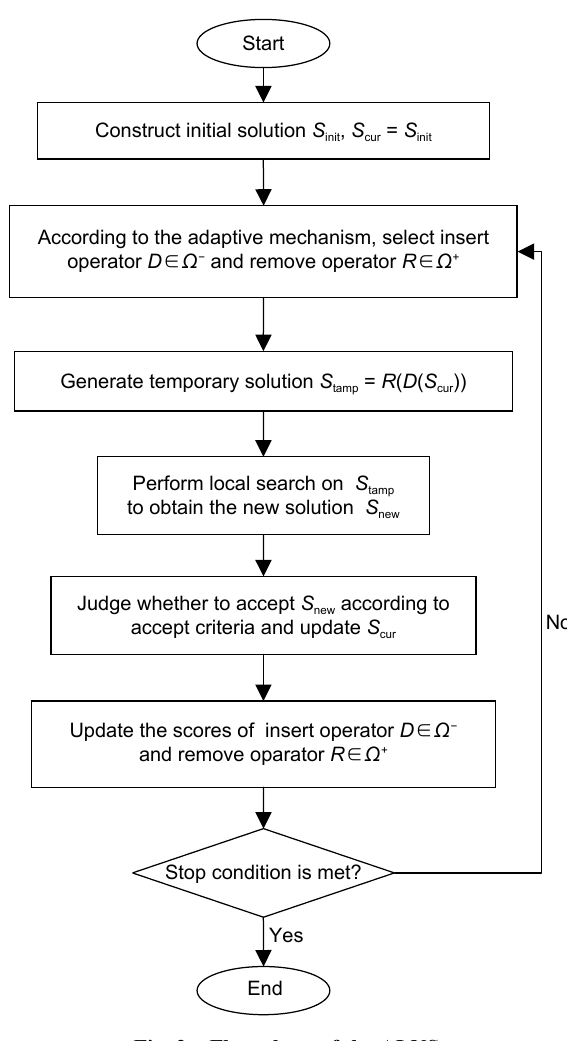
Fig. 2 Flow chart of the